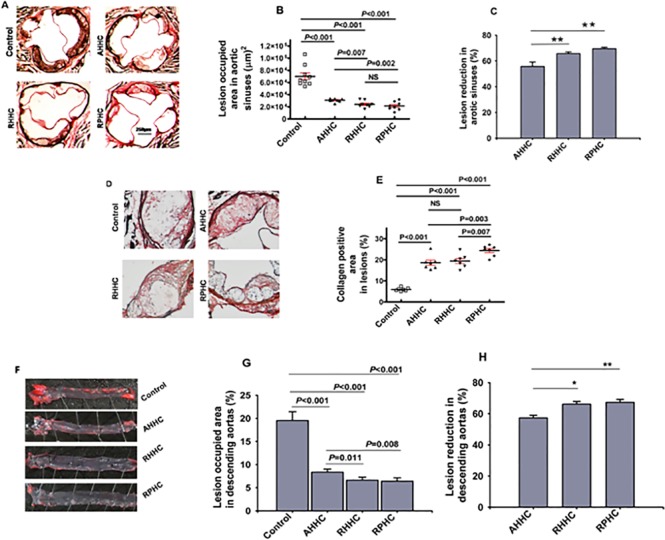
Detection and quantitation of the lesion areas in the aorta of B6;129S-Ldlr
tm1Her
Apob
tm2Sgy
/J mice fed on a high-fat diet after immunization with constructs versus controls (GST-Den).(A) Photomicrograph of lesions observed in atherosclerotic aortas as analyzed with elastin/van Gieson staining. (B) Scatter plot showing mean of lesion area in the aortic sinus of mice immunized with constructs compared with those in controls (GST-Den). (N = 6–9 mice). Error bars = SEM. (C) Percentage of reduction in lesion size in the aortic sinus (the reduction of control [GST-Den] group was set at zero). (D) Representative photomicrographs and quantitative analysis of collagen (Sirius Red coloration under polarized light) in atherosclerotic aortas in individual mice. (E) Quantification of collagen content at lesion area in the aorta of B6;129S-Ldlr
tm1Her
Apob
tm2Sgy
/J mice (N = 7 mice). NS: not significant. (F) Representative Oil Red O-stained en face descending aorta from mice. (G) Percentage of lesion-occupied area versus total area of descending aortas in individual mice (N = 6 mice) of the different experimental groups. The mean lesion size and the difference in lesion size between the experimental groups are shown. (H) Percentage of reduction in lesion size in descending aortas (the reduction of control [GST-Den] group was set at zero).